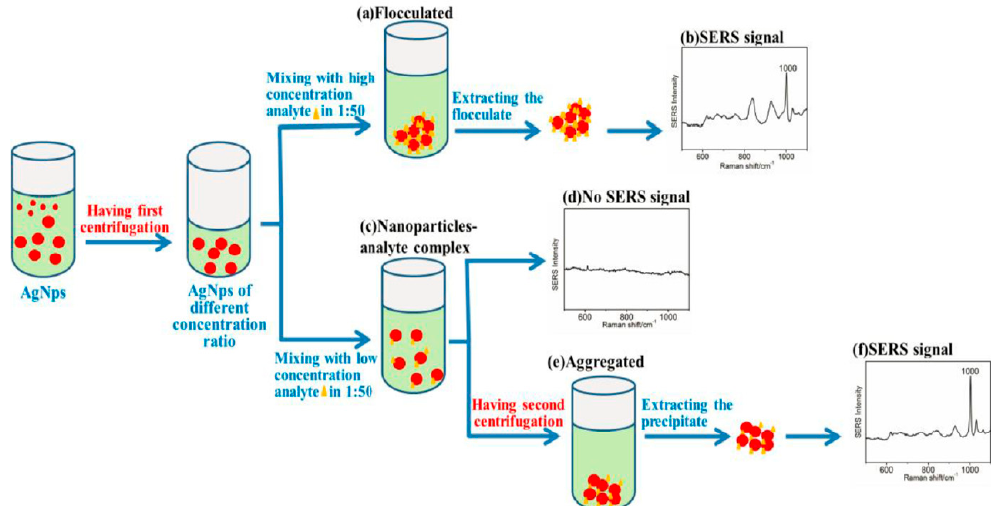
Figure 8. Diagram of the detection process of phenformin hydrochloride by the SERS-based two-step centrifugation method. ( a ) The concentrated AgNPs were flocculated when high concentration phenformin hydrochloride was added. ( b ) Characteristic peak of the phenformin hydrochloride were detected at 1000 cm − 1 . ( c ) The concentrated AgNPs were unflocculated, and an analyte-AgNPs complex was formed when a low concentration analyte was added. ( d ) No characteristic peak of the phenformin hydrochloride was detected. ( e ) An aggregated analyte-AgNPs complex and the interparticle gap decreased after the second centrifugation. ( f ) Characteristic peak of the phenformin hydrochloride were obvious at 1000 cm − 1 (Chen et al. [106]).